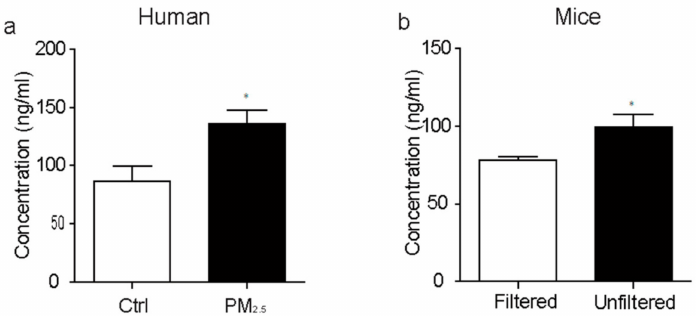
Figure 1. Exposure to ambient air particles up-regulate the concentration of plasma glucocorticoid in both human ( a ) p < 0.05, t22 = 2.085, and mice ( b ) p < 0.05, t18 = 2.608; * p < 0.05.